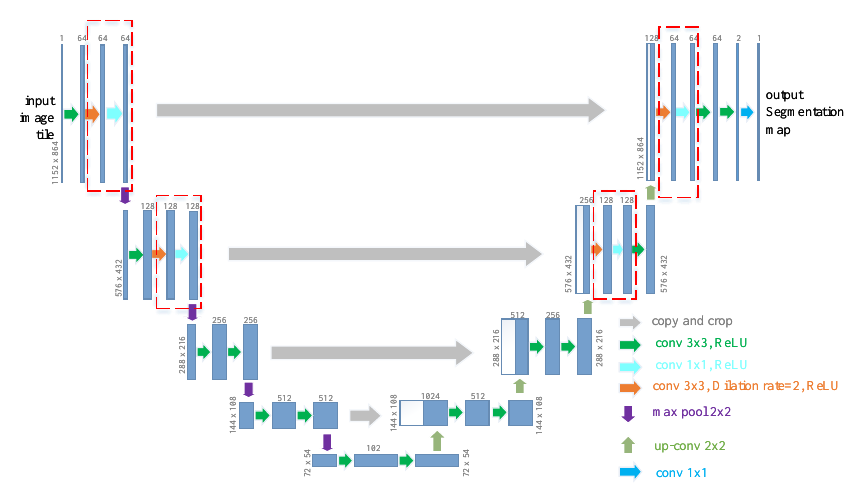
Figure 8. Structure of improved U-net model.